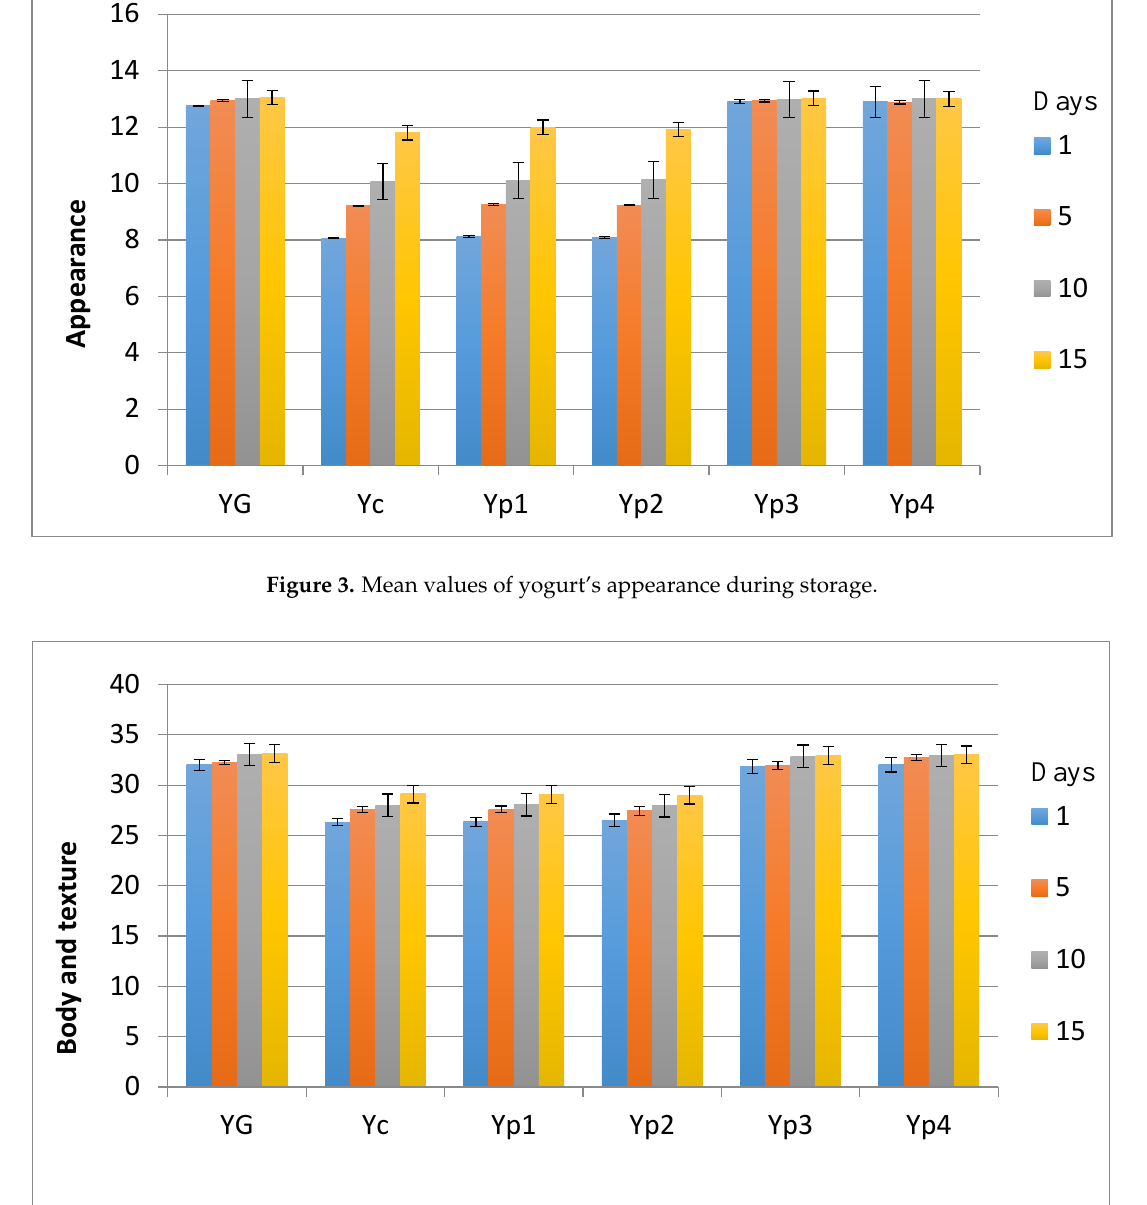
Figure 4. Mean values of yogurt’s body and texture during storage.